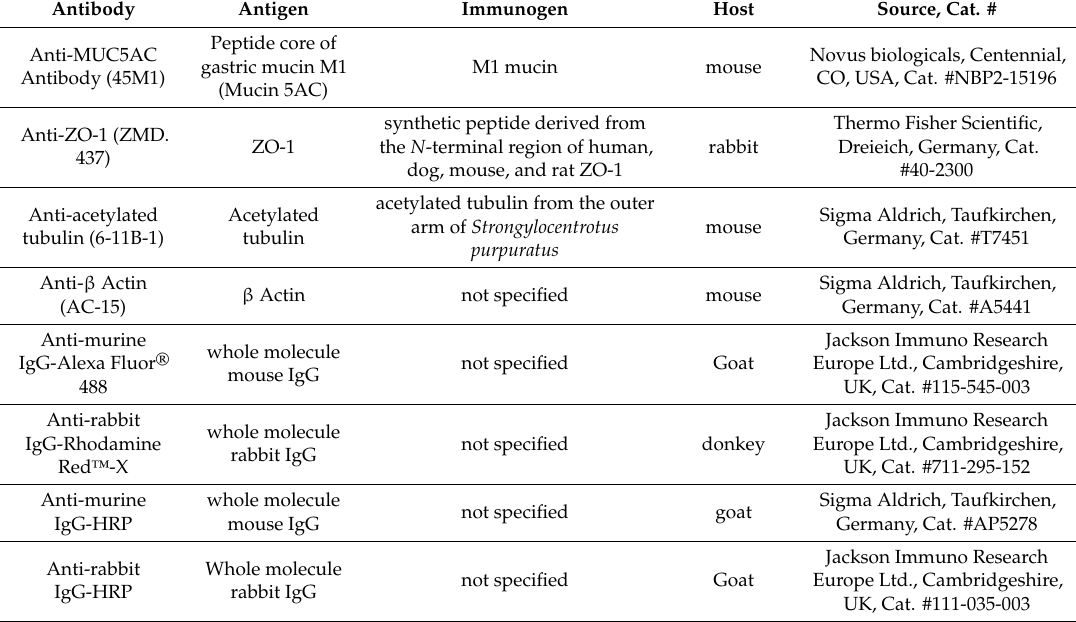
Table 2. List of antibodies used in this study. FITC: fluorescein-isocyanate; HRP: horseradish peroxidase; ZO-1: zonula